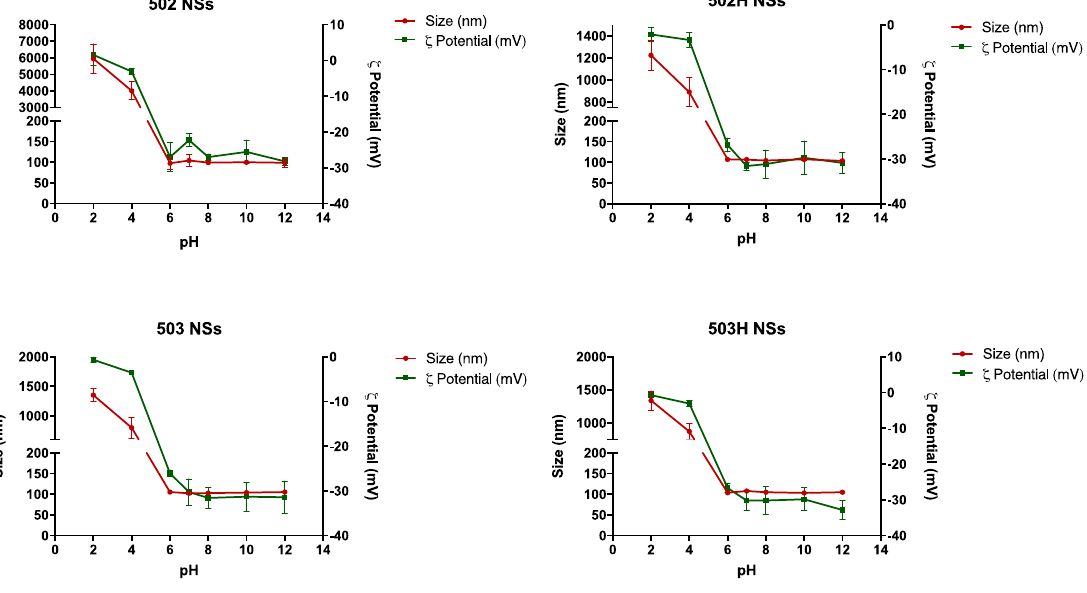
Figure 8. Changes in size and ζ potential values of lactoferrin-loaded PLGA NSs over the studied pH interval.